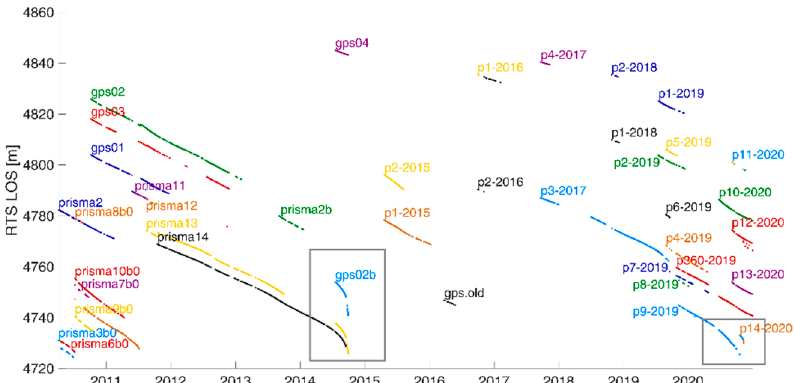
Figure 3. Reflective prisms installed onto the WS since 2010. The labels “gps” refer to prisms too. The ordinates report the evolution of the distance between every prism and the RTS. In September 2014 and November 2020, the acceleration of several prisms is visible in the grey boxes, which corresponds to ice break ‐ offs.